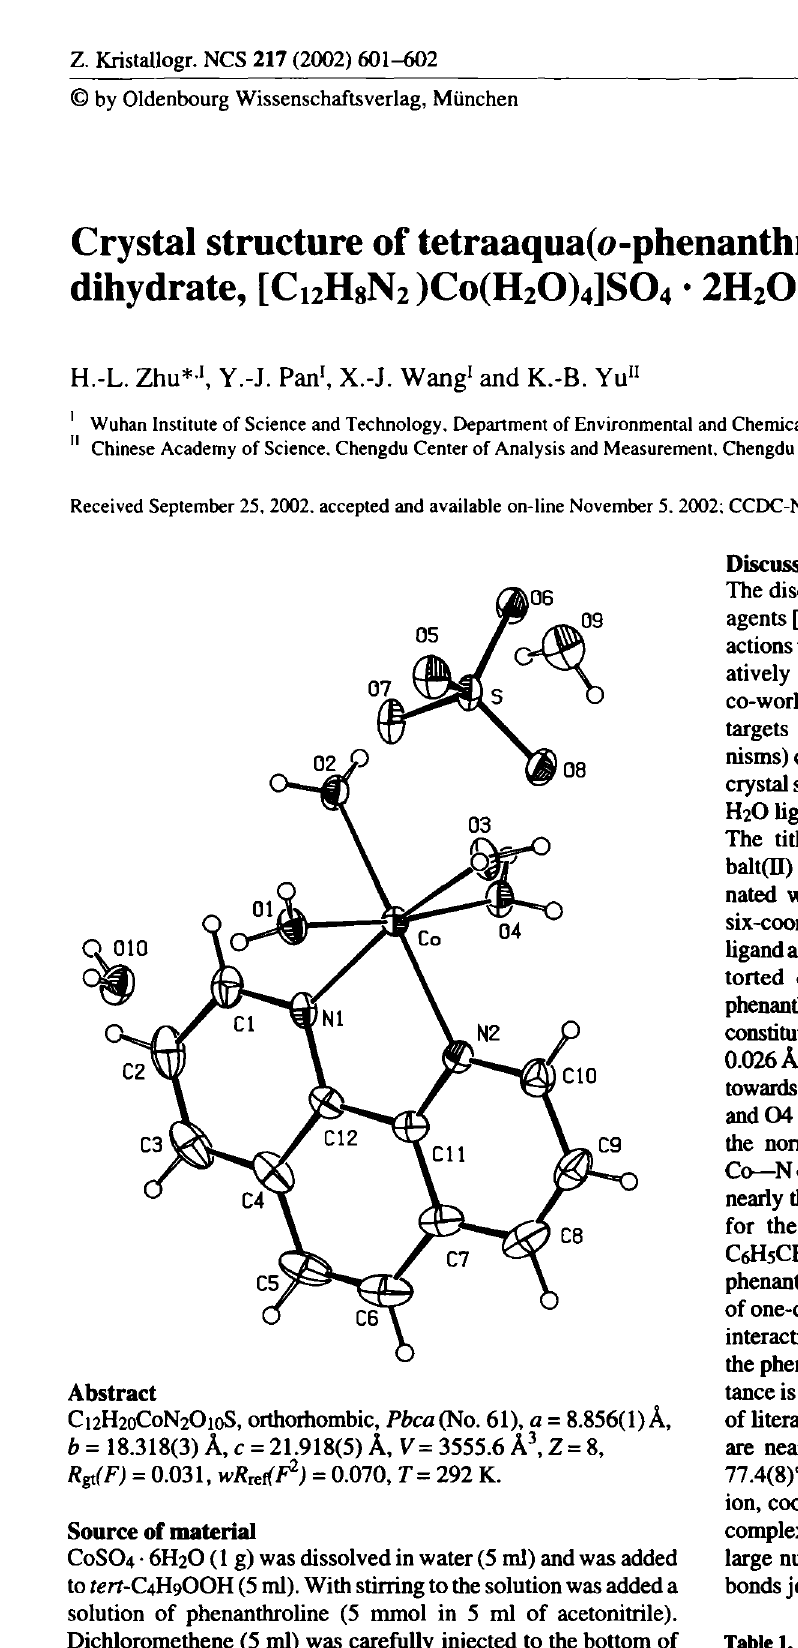
Table 1. Data collection and handling.